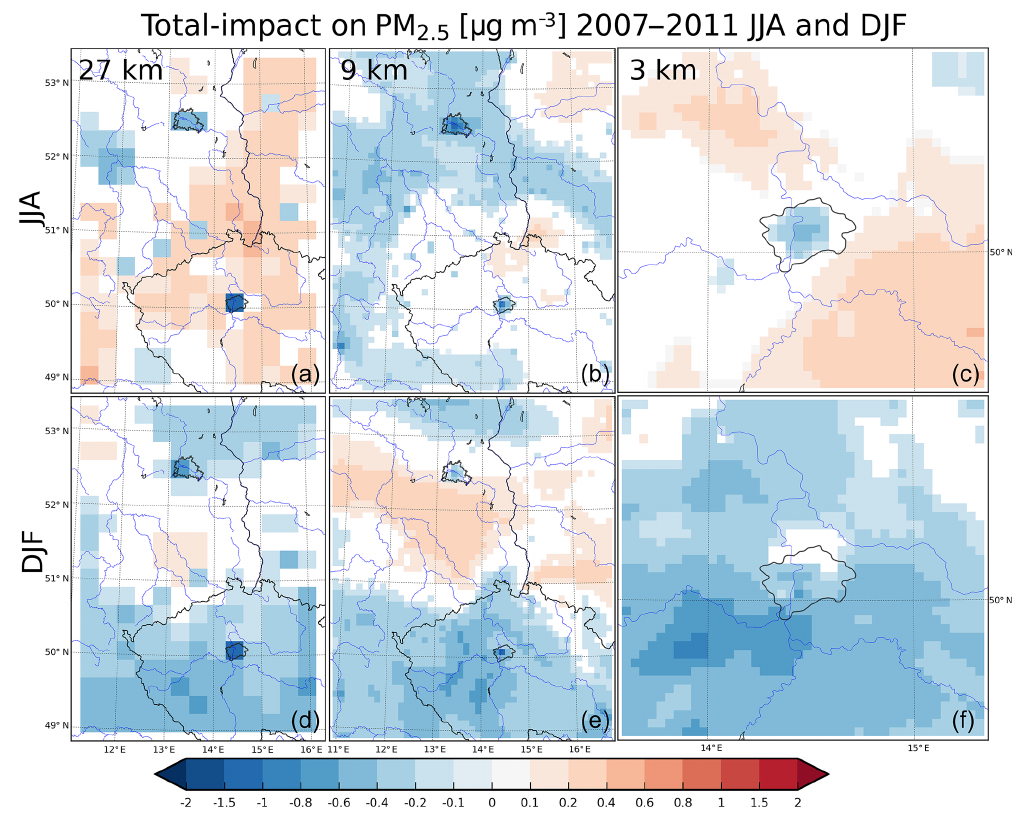
Figure 30. The total impact of urban meteorological changes (i.e., temperature, humidity, wind and vertical eddy diffusivity) on surface PM 2 . 5 concentrations in ppbv for the 27, 9 and 3km resolutions (left to right) for JJA (a, b, c) and DJF (c, e, f) . Shaded areas represent statistically significant changes on the 98% threshold level using a two-tailed t test. The default CMAQ K v method was invoked in this calculation. The geographic locations of Berlin and Prague are indicated by their administrative